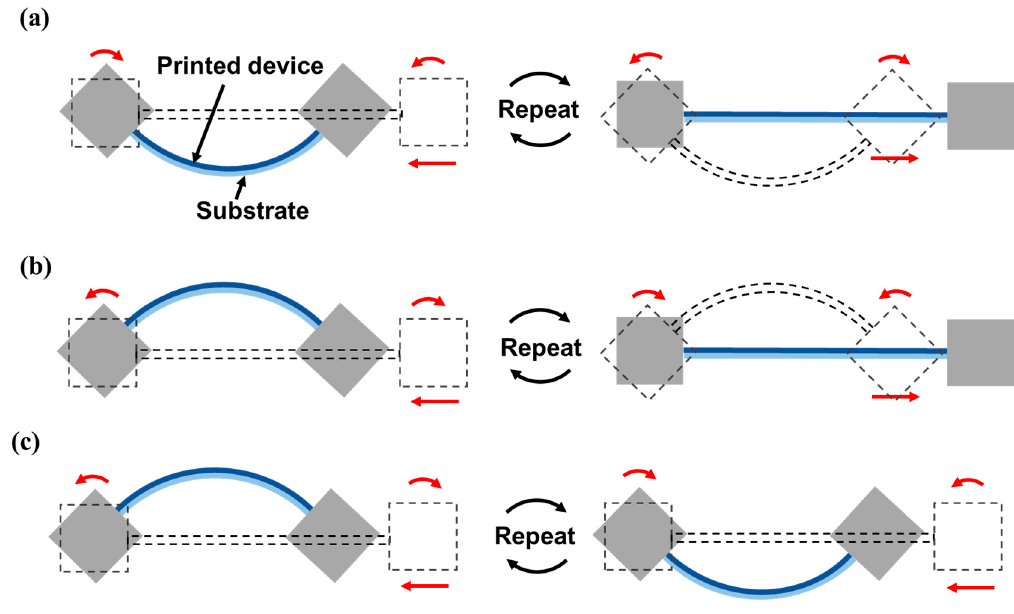
Figure 11. Schematics of printed antenna bending modes under different loadings: ( a ) compressive stress by one-sided bending (inner bending); ( b ) tensile stress by one-sided bending (outer bending); ( c ) alternating tensile and compressive stresses by two-sided bending (inner-outer bending). The specimens had initial resistances of 5 ± 0.3 Ω and their resistances were measured regularly